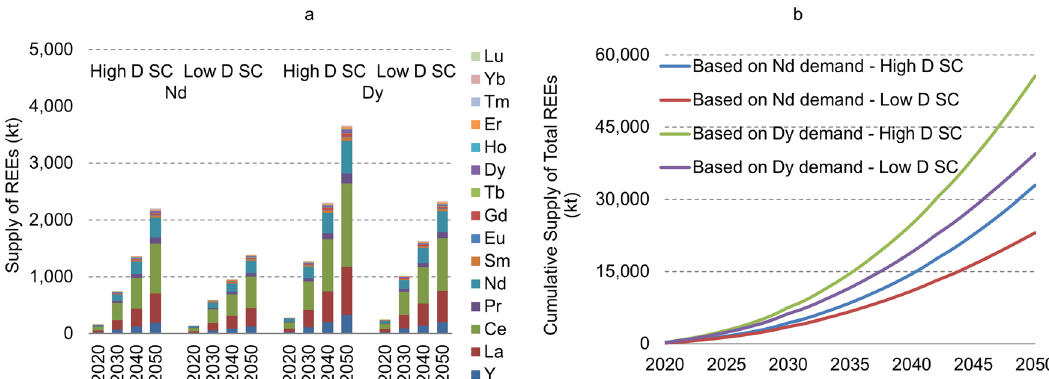
Fig. 2 REEs supply. a Annual supply of individual REEs; and b Cumulative supply of total REEs as a result of the demand for Nd and Dy in WP and EVs in the high and low demand scenarios.